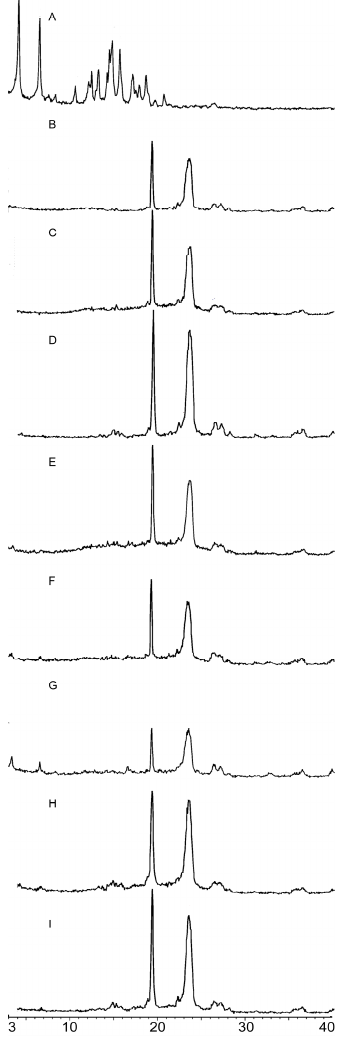
Fig ure 3. Powder X-ray diffractograms (PXRD) of PPD ( A ), PEG6000 ( B ), F68 ( C ), F1 ( D ), F2 ( E ), F3 ( F ), PEG6000 PM ( G ), F68 PM ( H ), PEG6000 and F68 PM (I).